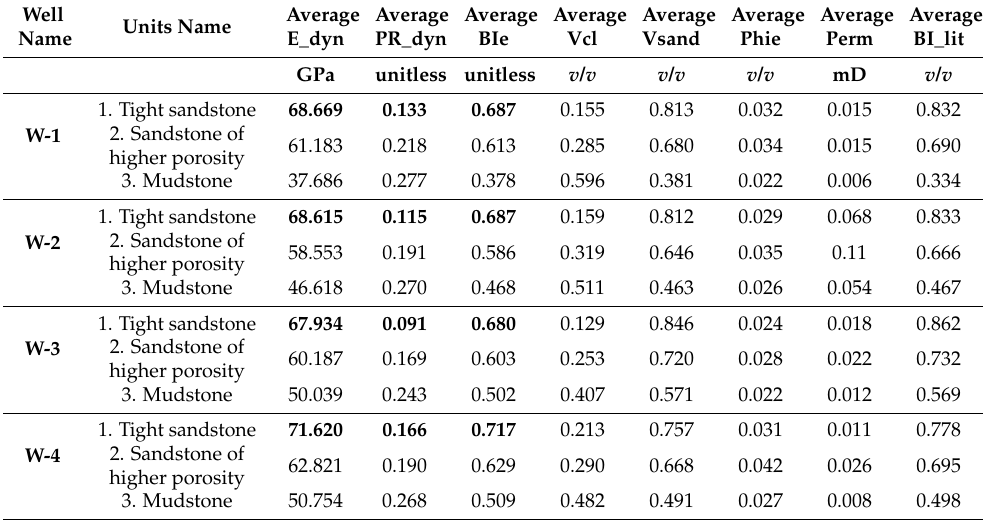
Table 2. The average values of dynamic elastic properties (E_dyn, PR_dyn), brittleness (BIe), shale volume (Vcl), volume of quartz (Vsand), effective porosity (Phie), absolute permeability (Perm), brittleness based on lithology (BI_lit) in three geomechanically different